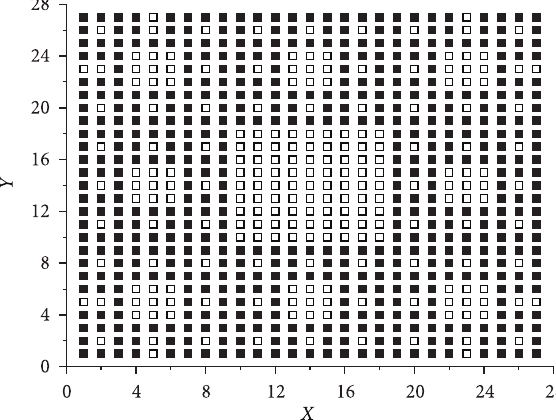
Figure 8: Principal u -cut radiation pattern for the first